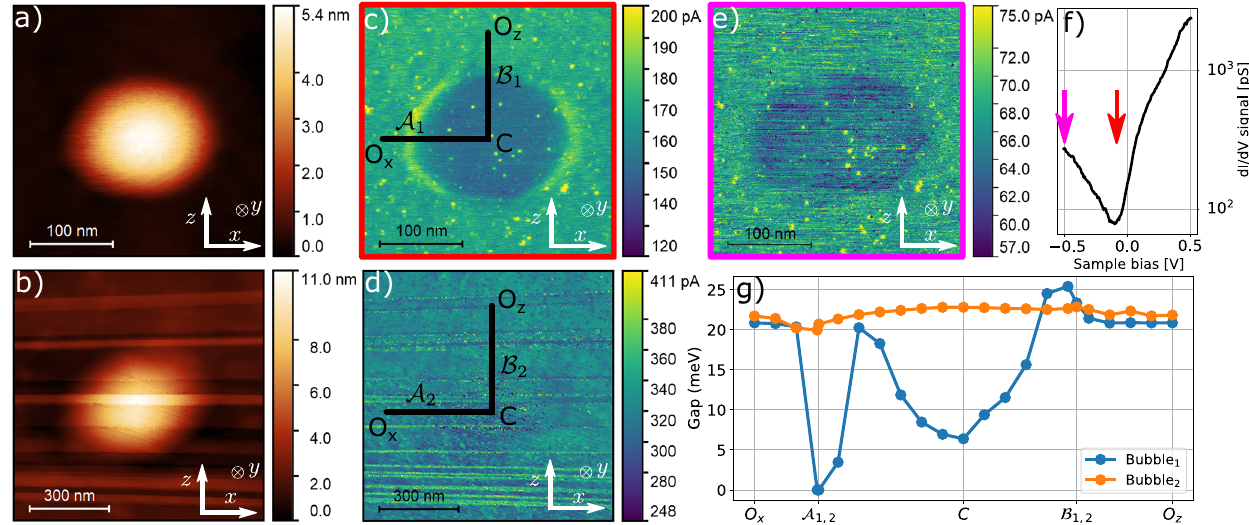
Fig. 2 Strain induced topological phase transition in ZrTe 5 bubbles. a STM topography image of Bubble 1 and b of Bubble 2 . c Map of the d I / d V signal in the same area as in a ), measured within the gap. Bright dots on the d I /d V image are point defects. d Map of the d I /d V signal in the same area as in b of Bubble 2 . e Map of the d I /d V signal in the same area as in panel c but at – 500 mV sample bias, deep in the valence band. f d I /d V spectrum measured on the sample surface far away from Bubble 1 . Colored arrows highlight the sample bias used to measure the d I /d V image in panel c and e . The minimum of the d I /d V signal corresponds to the gap and has a value of 78 pS. g Band gap of ZrTe 5 resulting from ab initio calculations, along the path depicted in c and d . The gap, and as a consequence the LDOS, is modulated by the locally varying strain within the bubbles (see Fig. 3). STM measurement parameters: 300 K, 500 pA, sample bias for a – d – 100 mV and – 500 mV for panel e .